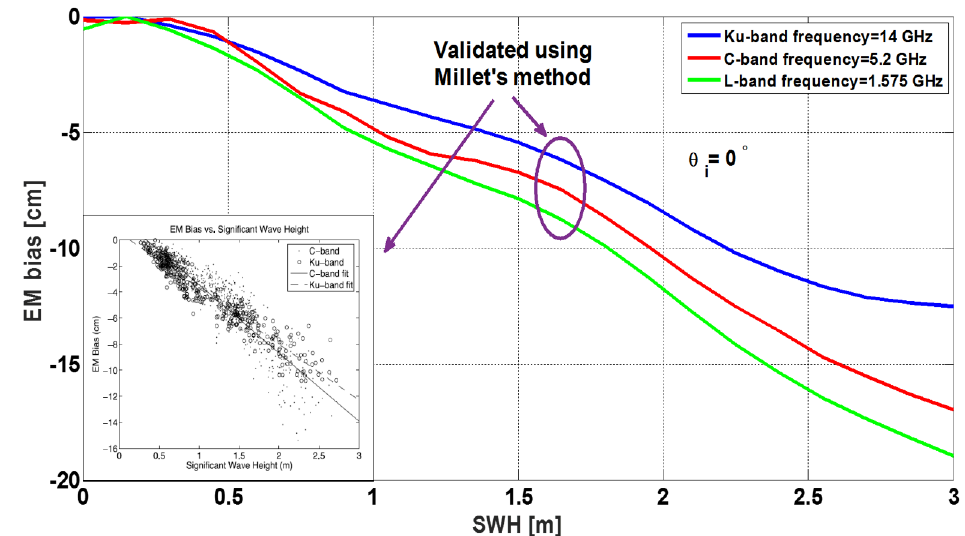
Figure 2. EM bias estimated using Millet’s et al. model, at C- (red) and Ku- (blue)-bands (Figure 8 from [13]), and extrapolated results at L-band (green) as a function of the Significant Wave Height (SWH). Modified from Figure 5 in